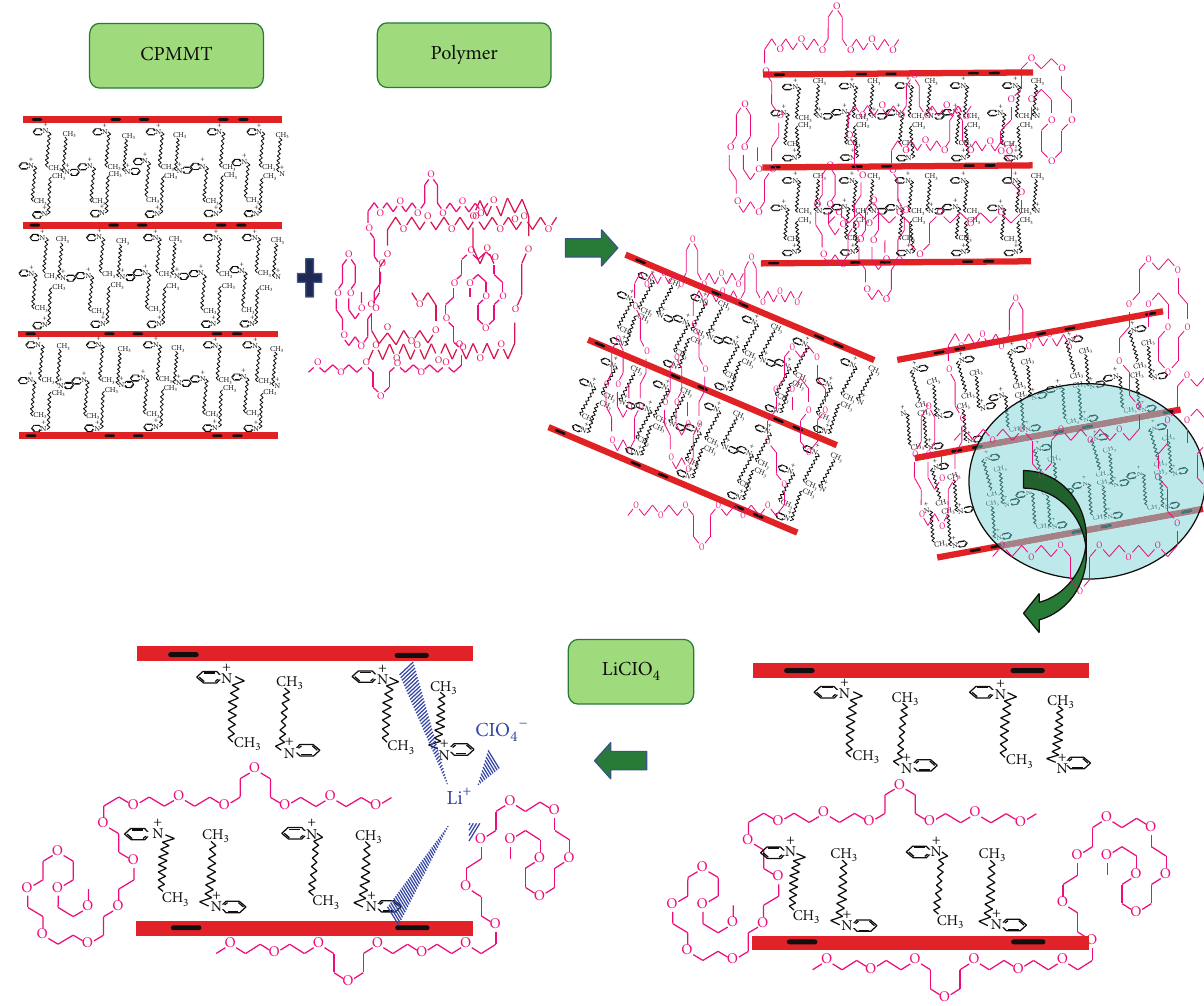
Figure 5: Mechanism of PEO-Salt/CPMMT